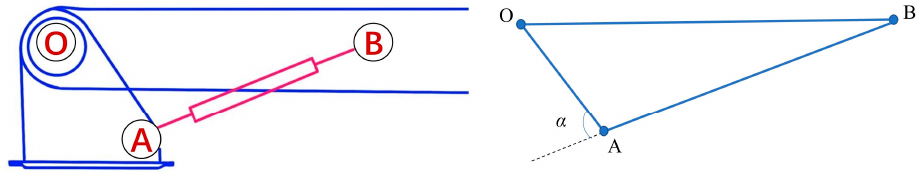
Figure 2. Schematic of cylinder #1 and its linkage mechanism.